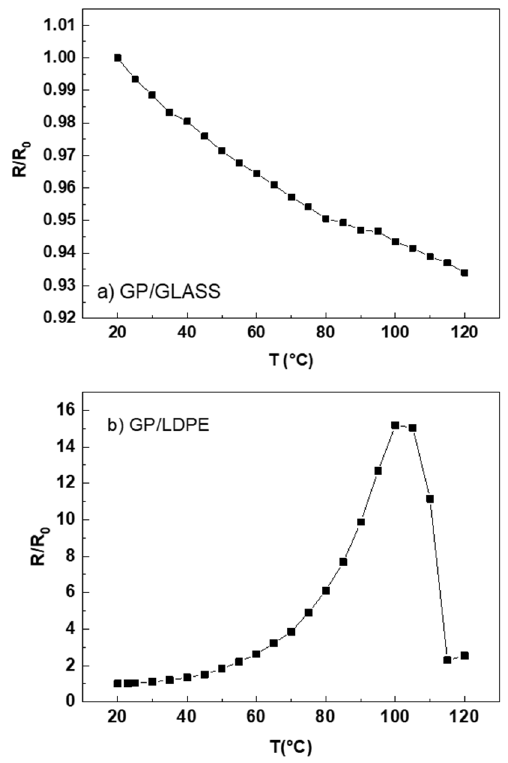
Figure 9. Ratio of the resistance R to the initial resistance R 0 at 20 °C (R/R 0 ) vs. temperature, T, for GP films deposited on glass ( a ) and LDPE ( b ) substrates. Black lines are guides.